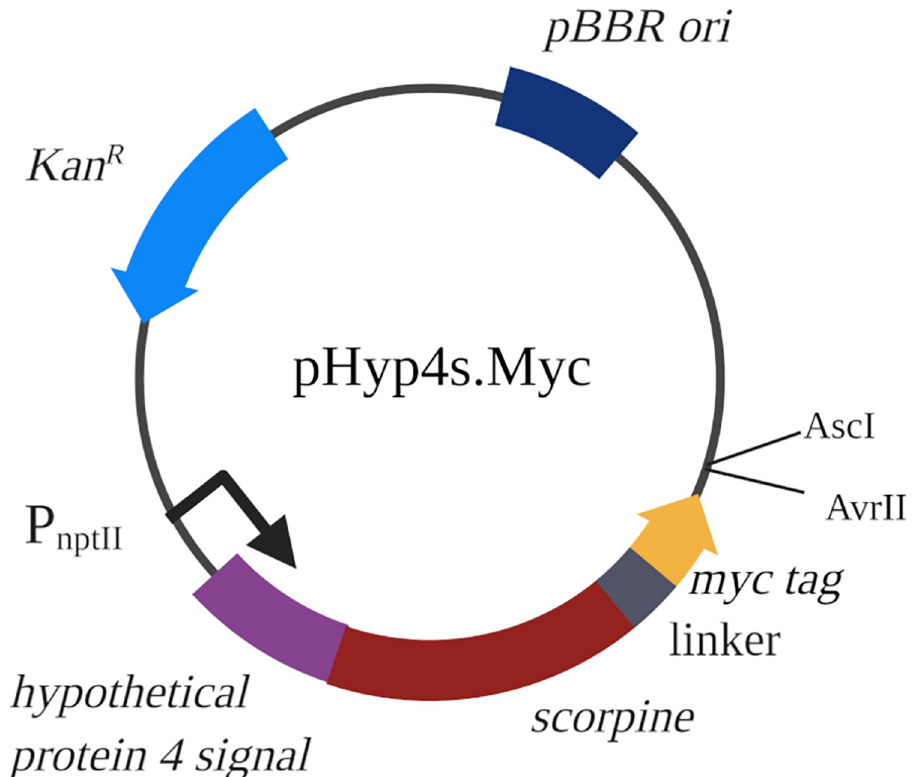
Fig 1. Antiplasmodial vector pHyp4s.Myc. This plasmid was created for fusion partner protein insertion by replacing the alkaline phosphatase region of Hyp4s (PhoA) [31] with a Myc tag and restriction enzyme recognition sites. The partner protein genes were inserted between the AvrII and AscI restriction sites for in frame fusion with the preceding Myc tag. pBBR, origin of replication; Kan R , kanamycin resistance; P nptII , promoter; hypothetical protein 4 signal, signal sequence for extracellular release of protein; scorpine, antiplasmodial effector protein; linker, (GGGGS) 3 flexible linker. Created with